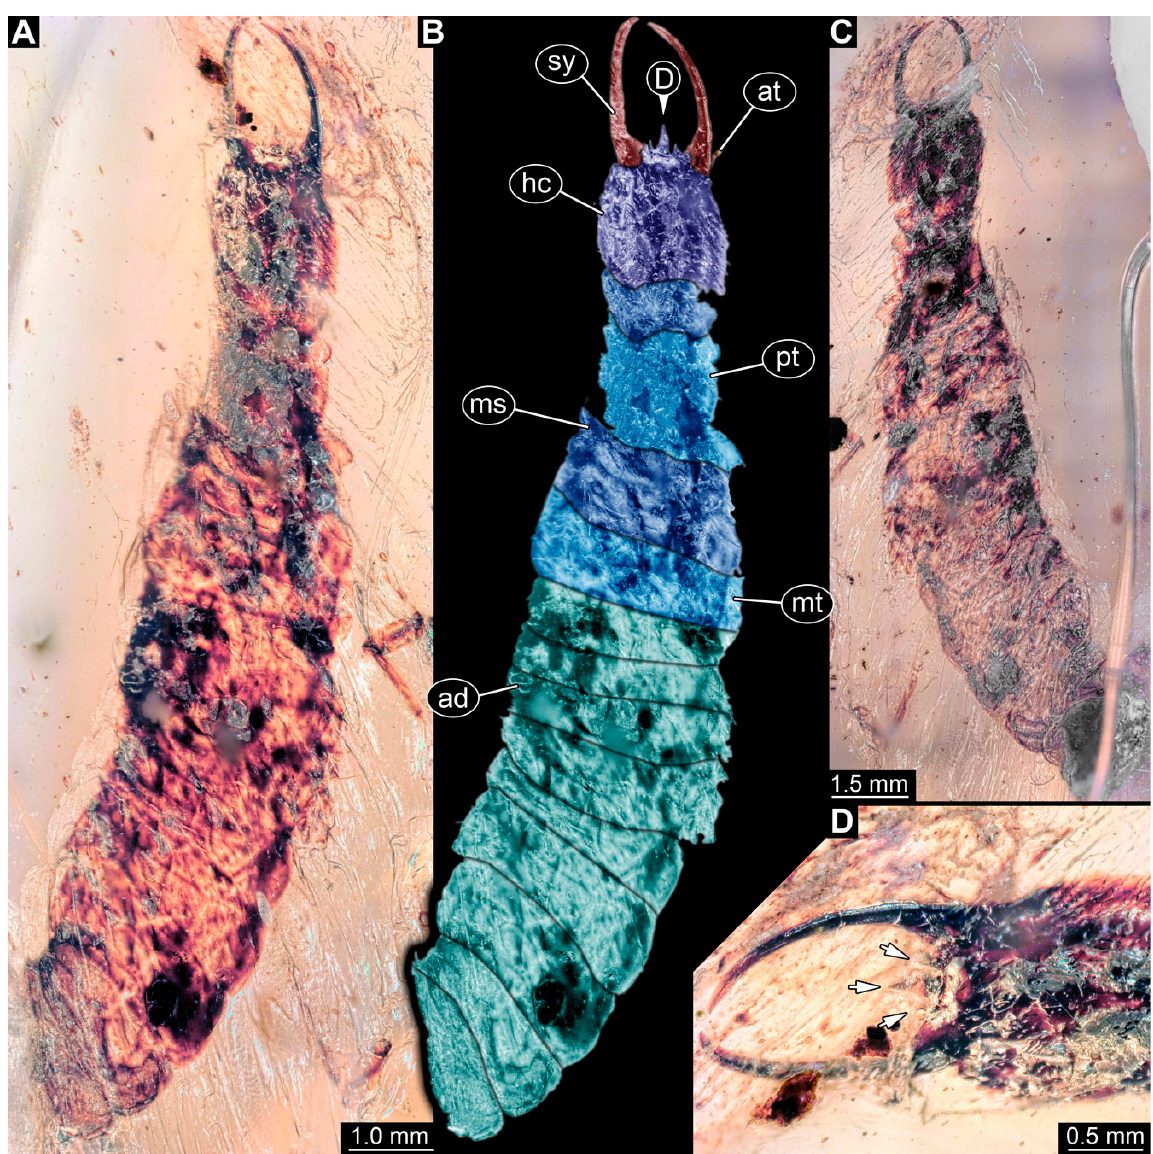
Figure 23. Specimen 88 (PED 1967); Myanmar amber. ( A ) Dorsal view. ( B ) Dorsal view, colour- marked. ( C ) Ventral view. ( D ) Close-up of head capsule in ventral view; arrows mark spine-like protrusions of the labrum. Abbreviations: ad = abdomen; at = antenna; hc = head capsule; ms = mesothorax; mt = metathorax; pt = prothorax; sy = stylet.